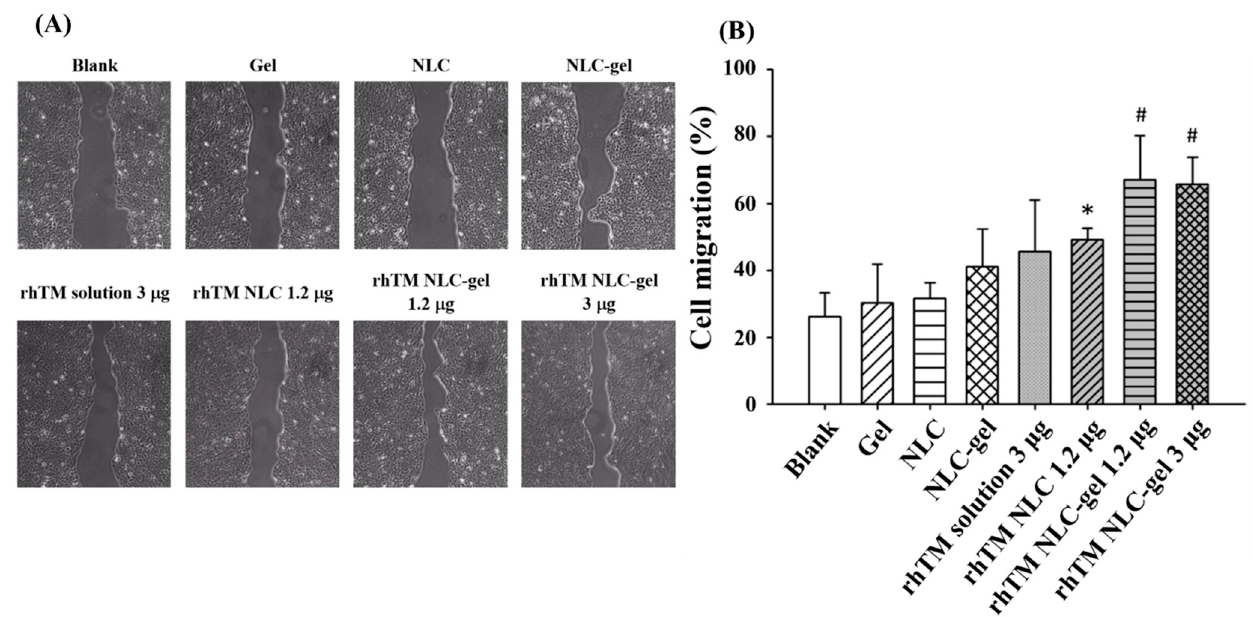
Figure 6. RhTM NLC-gel 1.2 µg enhanced cell migration of human keratinocyte HaCaT cells. The cells were seeded, treated with different formulations, and then photographed using OPTIKA camera and Leica microscopy system. ( A ) Representative images were shown. ( B ) The ratio of wound recovery was quantitatively determined with ImageJ software. Data are presented as mean ± SD ( n = 4 each treatment). The significance was analyzed using Student’s t-test. p < 0.05 compared with Blank/Gel/NLC group (*) or Blank/Gel/NLC/rhTM NLC 1.2 µg group (#).